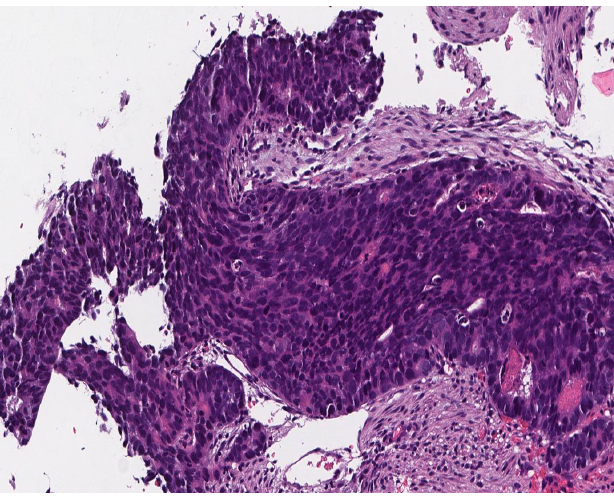
Figure 6. Carcinoma Small cell lung.